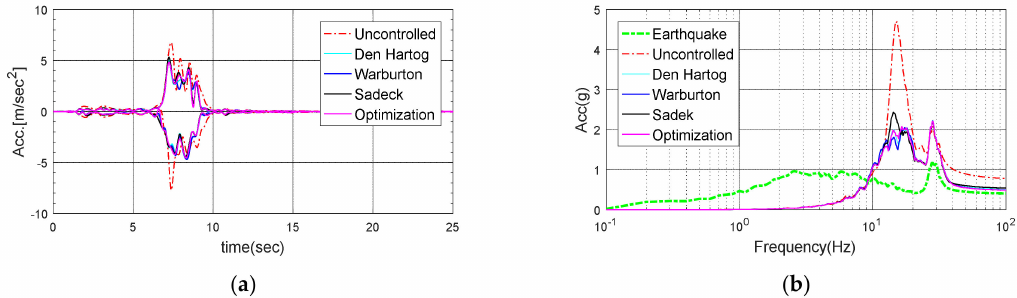
Figure 23. Response of the electrical cabinet subjected to Northern Calif-03: ( a ) Time history; ( b ) Response